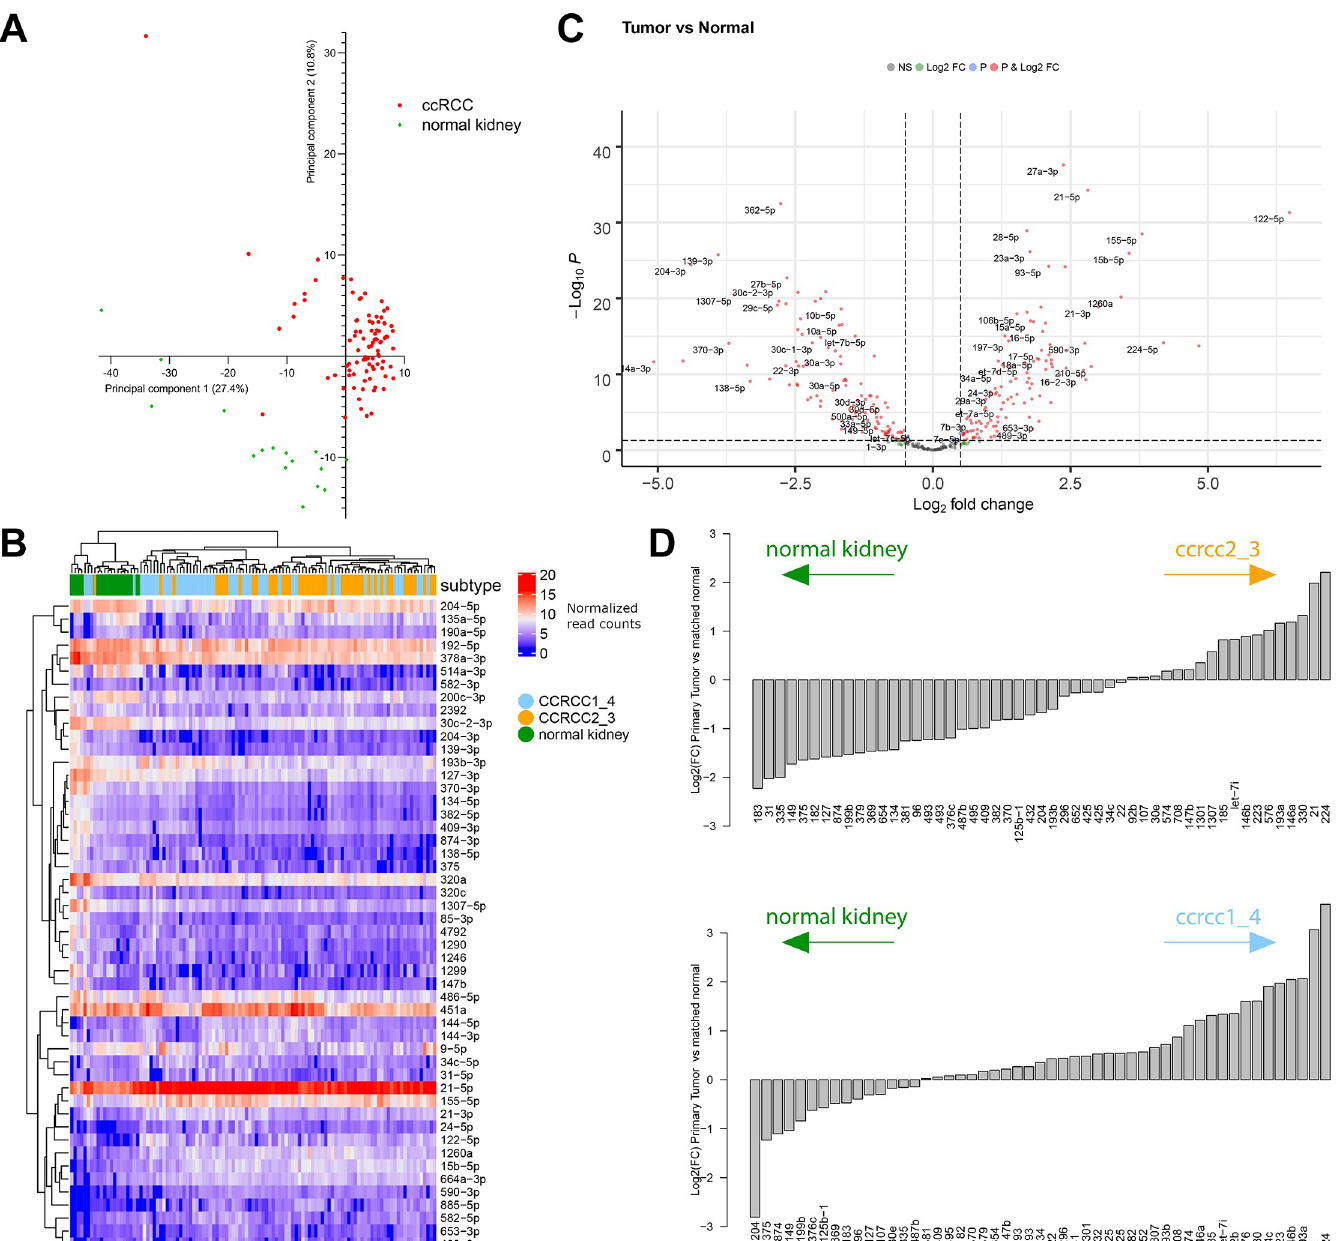
Fig 1. Exploratory analyses of all samples (tumor and normal kidney combined, Leuven dataset). These showed a marked separation of normal vs tumoral kidney samples. (A) Principal component analysis (n = 111). (B) Unsupervised cluster analysis of the 50 most variable miRNA (n = 111). (C) Volcano plot (n = 95). (D) Significantly differently expressed miRNAs between matched normal and tumoral samples (n = 16). In panels C and D, higher positive fold changes indicate higher expression in tumor samples and lower negative fold changes indicate higher expression in normal kidney.